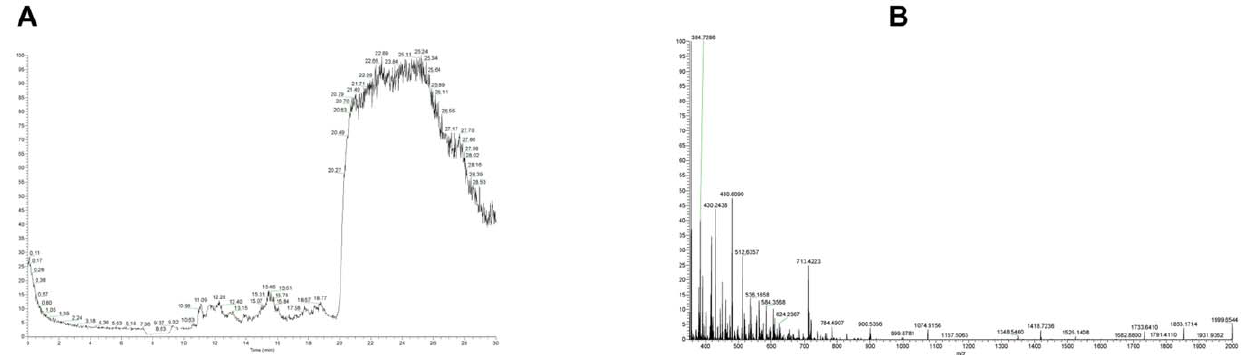
Figure 3. Flow through fraction of non-digested oxidized synthetic hPTH(1–84)ox from the affinity column. A : NanoLC-ESI-FTMS total ion chromatogram. B : Magnified summed FTMS spectrum for retention time interval of 16.50–18.50 minutes. The spectrum does not show any analyte masses which belong to PTH or oxidized PTH.